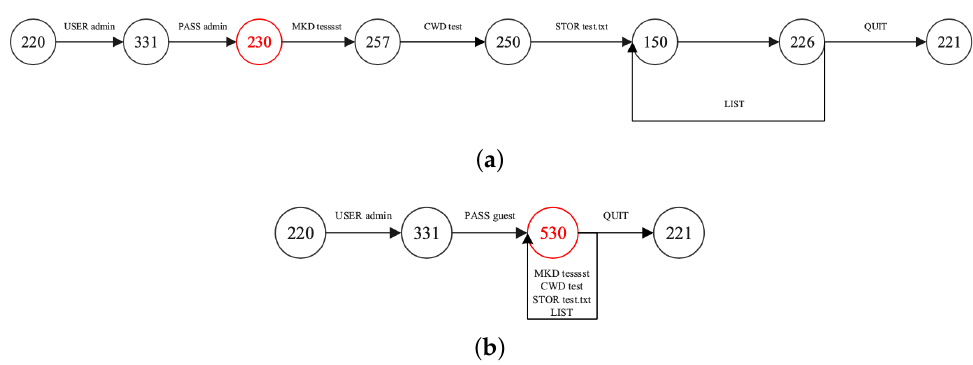
Figure 3. State transition diagrams produced when different states are selected for testing. ( a ) 230 as a state to be tested. ( b ) 530 as a state to be